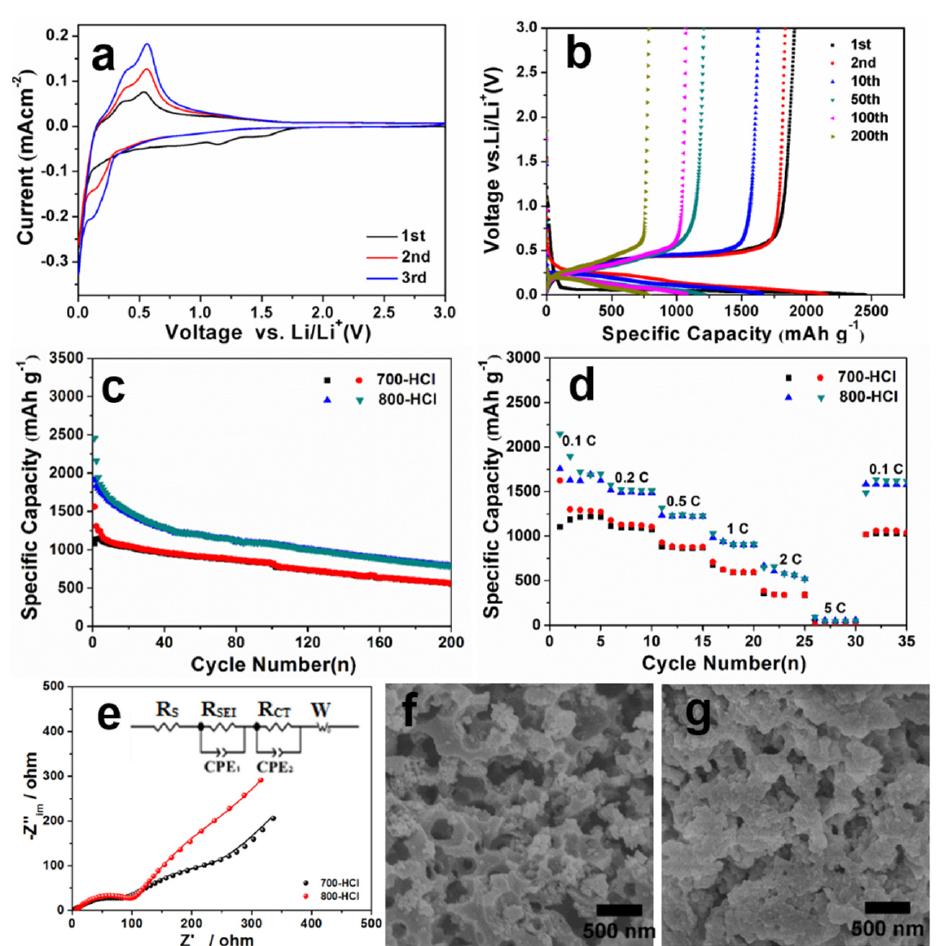
Figure 2. Cyclic voltammetry curves ( a ) (scanning rate: 0.2 mV s − 1 ), galvanostatic discharge/charge profiles ( b ), cycling performance ( c ) (current density: 0.2 C), and rate performance ( d ) of the 700-HCl and 800-HCl samples. Experimental (symbols) and fitting (lines) of the electrochemical impedance spectroscopy profiles of the 700-HCl and 800-HCl samples after 200 cycles at a current density of 0.2 C (( e ), the sub-figure is the equivalent circuit model). SEM images of the 800-HCl electrode before ( f ) and after 200 cycles ( g ). CC, charge capacity; DC, discharge capacity.